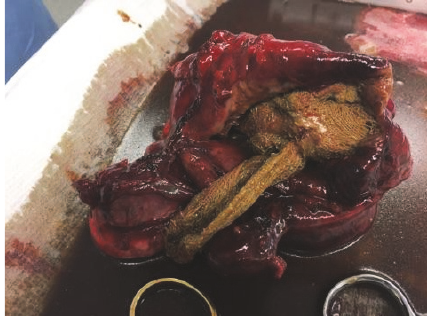
Figure 4: Postoperative photo of dissected gossypiboma specimen showing the retained laparotomy sponge from our patient’s previous